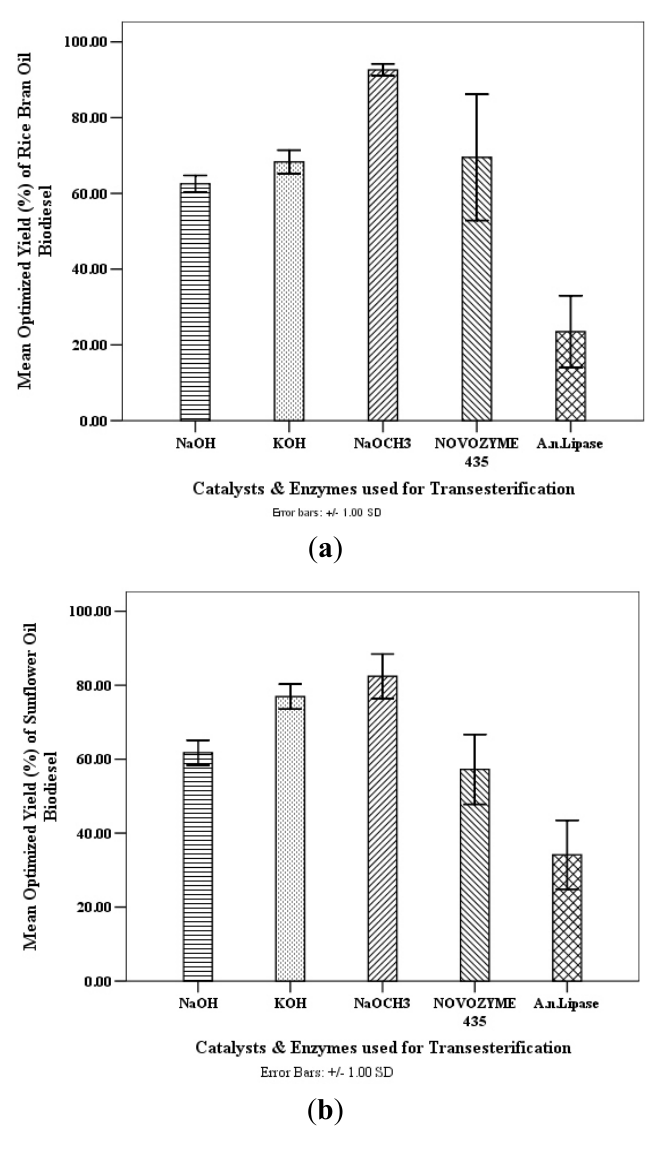
Figure 2. ( a ) Optimized rice bran oil and ( b ) Optimized sunflower oil based biodiesel yields (%) for chemical and enzymatic